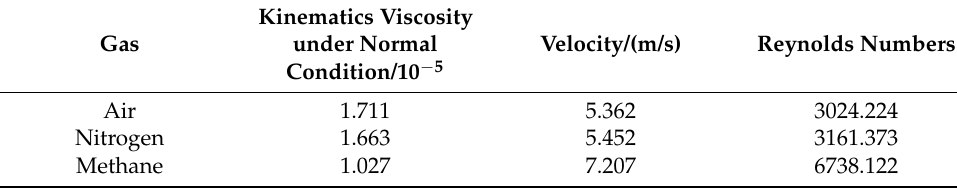
Table 9. Parameters of different gases.